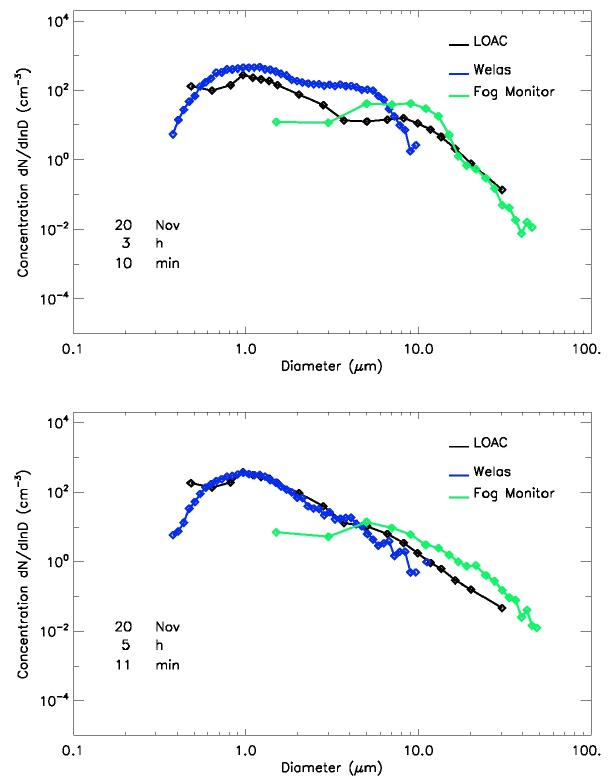
Figure 11. Cross-comparison of the three instruments at the be- ginning of the fog event (top) and at the end (bottom), during the ParisFog campaign on 20 November 2012 during a fog event. The LOAC uncertainties are ± 20% for the higher concentrations and ± 40% for the lower concentrations.